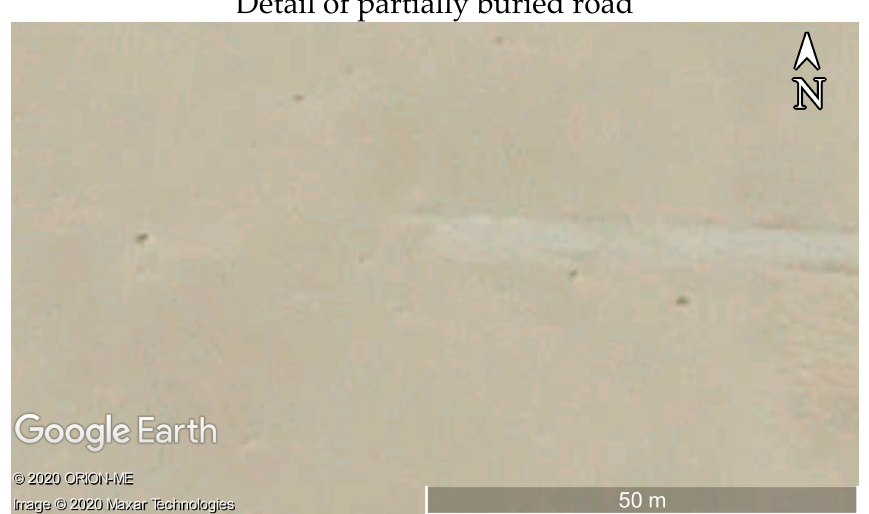
Figure 10. Close–up of the buried road segment shown in the very high resolution (VHR) optical data available on Google Earth Pro. The area corresponds with that shown by the red arrow in Figures 7 – 9. The imagery date is reported to be 5 May 2010.